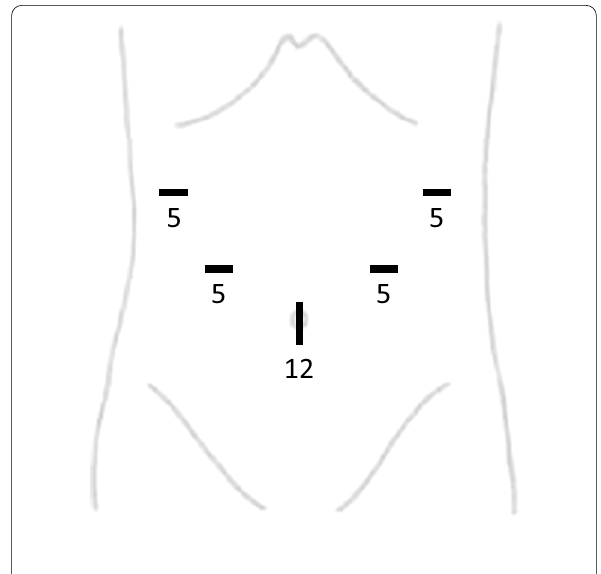
Fig. 2 A schema of laparoscopic ports placement. A 12-mm umbilical port and four 5-mm working ports were placed in the bilateral epigastric and hypogastric regions